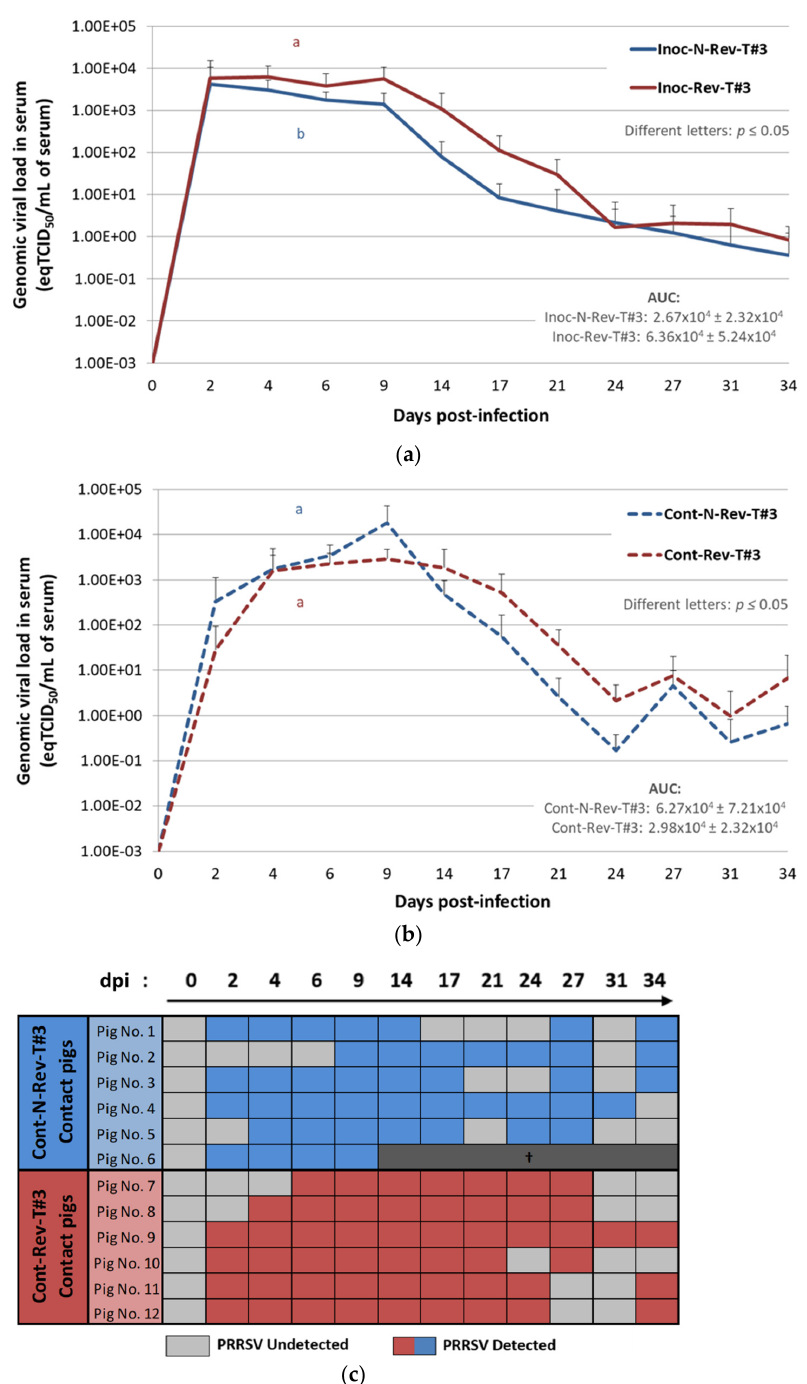
Figure 5. Porcine reproductive and respiratory syndrome virus (PRRSV) genomic quantification or detection in serum of inoculated and contact pigs during Trial#3. Evolution of the mean genomic viral loads in serum (eqTCID50/mL of serum) in inoculated non-revertant Trial#3 (Inoc-N-Rev-T#3) and inoculated revertant Trial#3 Inoc-Rev-T#3 inoculated pigs ( a ) and in Cont-N-Rev-T#3 and Cont-Rev-T#3 contact pigs ( b ) after inoculation (day 0) during Trial#3. Different letters (“a” and “b”) indicate that the groups are significantly different from each other after comparison of area under the curve (AUC) values with p ≤ 0.05. Data obtained from the Cont-N-Rev-T#3 pig euthanized at 10 dpi were not included in the average viral load AUC in serum. ( c ) Individual detections of viral genomes in the serum of Cont-N-Rev-T#3 and Cont-Rev-T#3 contact pigs. Transmission Parameters Transmission parameters including daily transmission rate and duration of latency were estimated during Trial#3 for N-Rev and Rev strains. Both N-Rev and Rev strains displayed the same duration of latency: 0.7 days [0.4; 1.5] (Table 2). However, the trans- mission rate for the Rev strain (0.75 [0.29; 1.90]) was significantly higher than for the N- Rev strain (0.58 [0.23; 1.69]). Table 2. Estimation of transmission parameters from Inoc-N-Rev-T#3 inoculated pigs (passage two) to Cont-N-Rev-T#3 contact pigs (passage three) and from Inoc-Rev-T#3 inoculated pigs (passage three) to Cont-Rev-T#3 contact pigs (passage four). Transmission Parameters